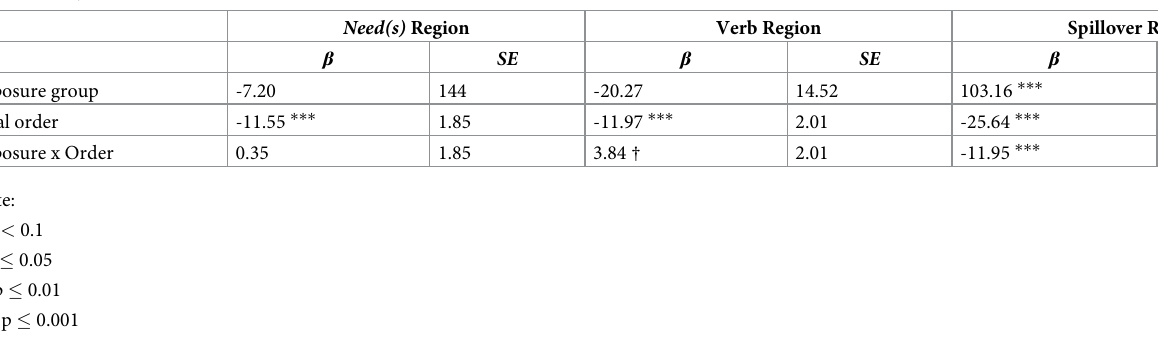
Table 2. Experiment 1 exposure block fixed effects summary for the three regions of analysis: The need (s) region, the critical verb region, and the spillover region (i.e., verb + 1).